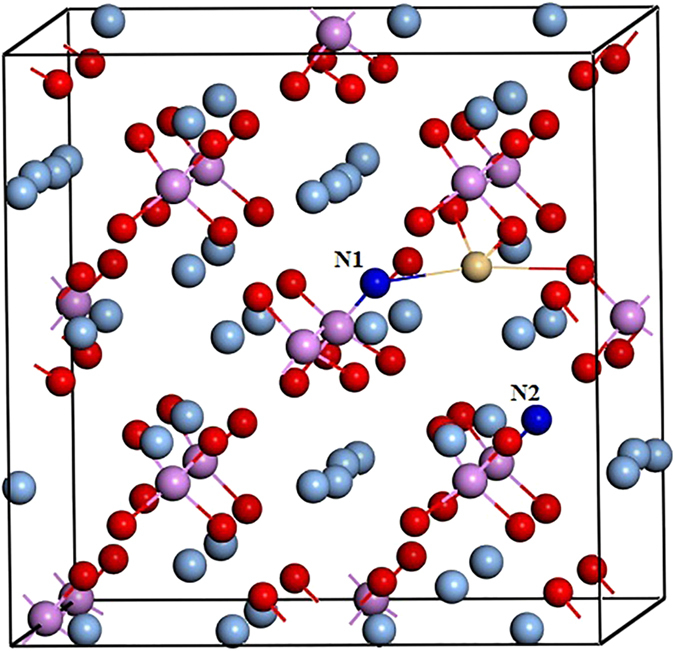
Crystal structure of Ag3PO4 supercell with codoping of CdAg and two NO.The silver, pink, red, khaki and blue balls represent Ag, P, O, Cd and N atoms, respectively.